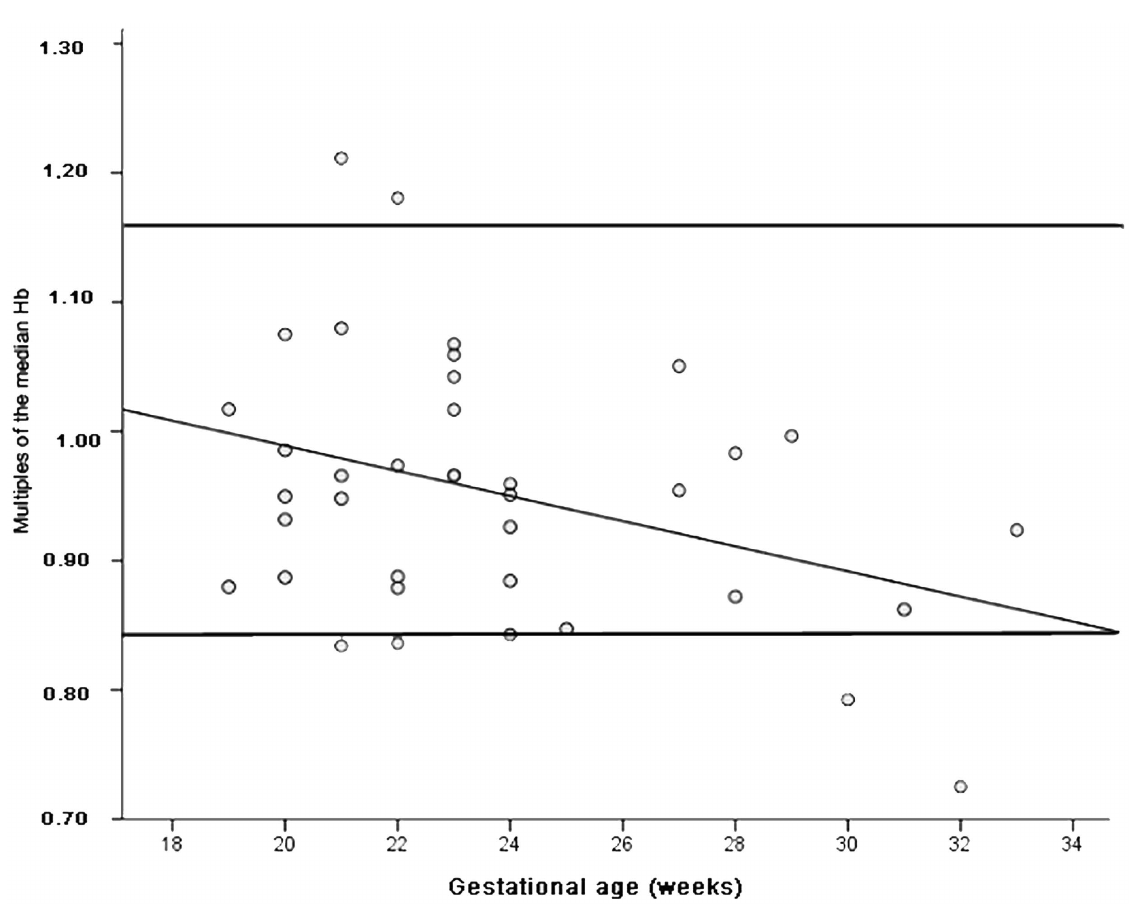
Figure 3. Hemoglobin concentration in fetuses with urinary tract malformations. Multiples of the median hemoglobin (MoM Hb) during the course of pregnancy in fetuses with isolated malformations of the urinary tract (n=38). Horizontal lines: Upper and lower limit, reference range [17]. R 2 =0.127. Equation for the line: y=1.183–0.010 x GA (gestational age).